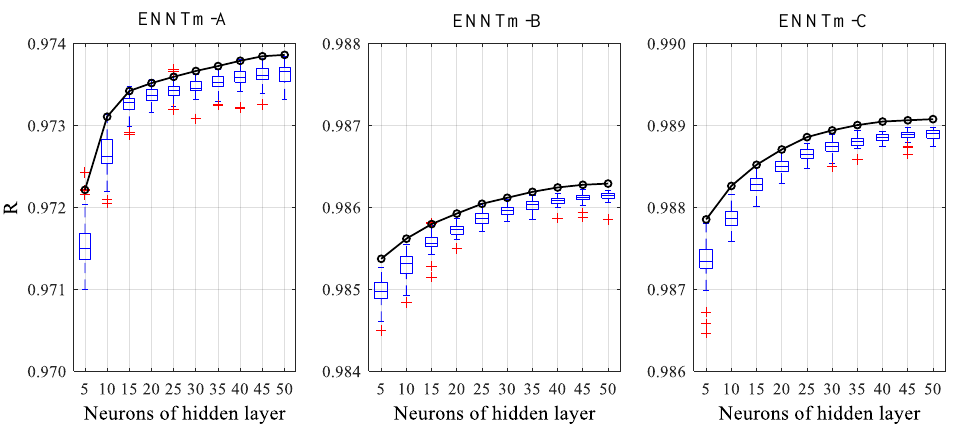
Figure 7. The Pearson correlation coefficient (R) of different modeling schemes with different BPNN